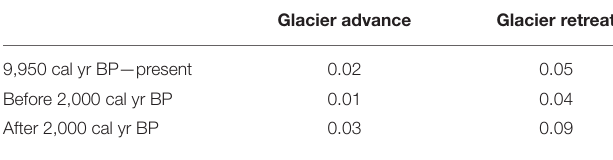
TABLE 2 | Probability of fire episodes at times of glacier advances or glacial retreat. Glacier advance Glacier